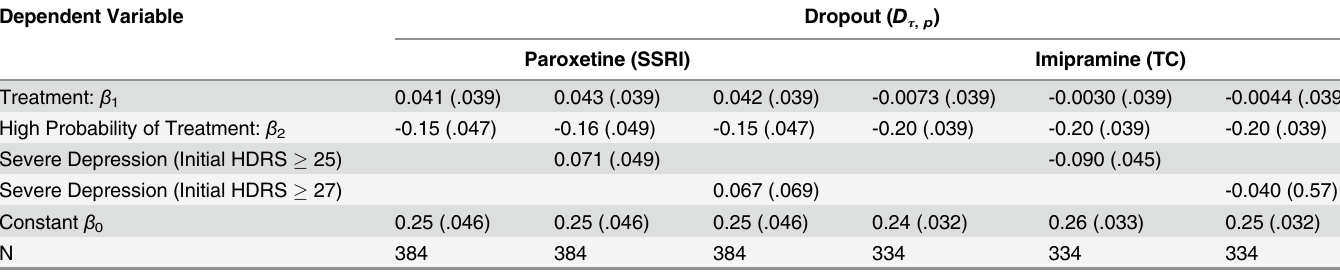
Table 3. Controlling for the effects of initial severity of depression in anti-depressant